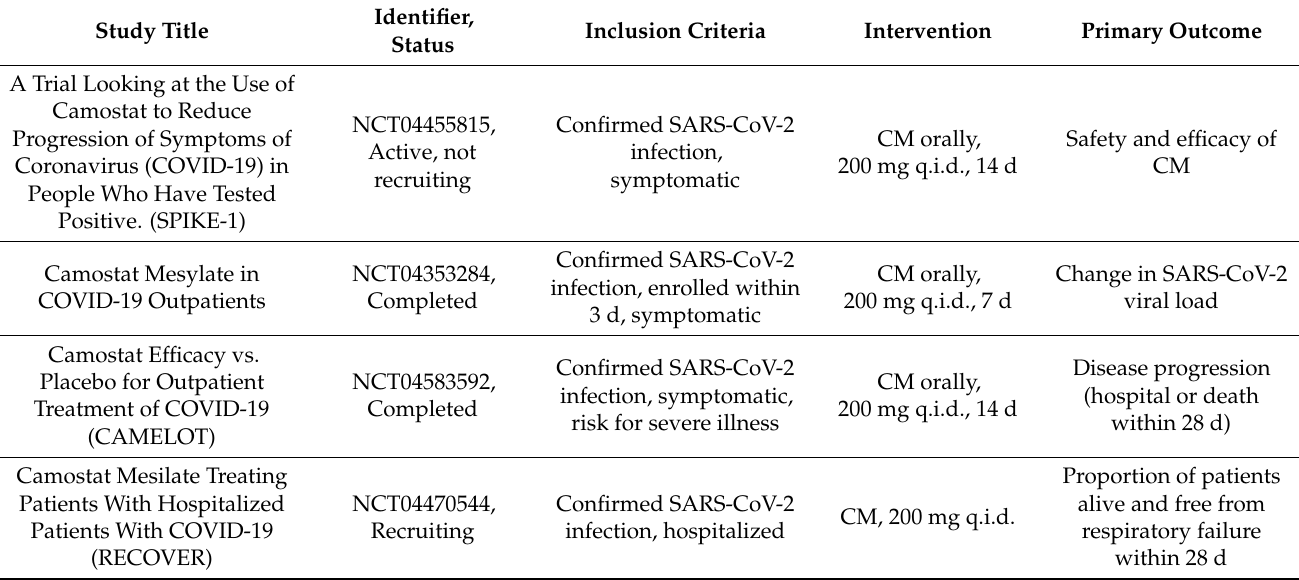
Table 2. Overview of initiated and completed clinical studies on TMPRSS2 inhibitors for